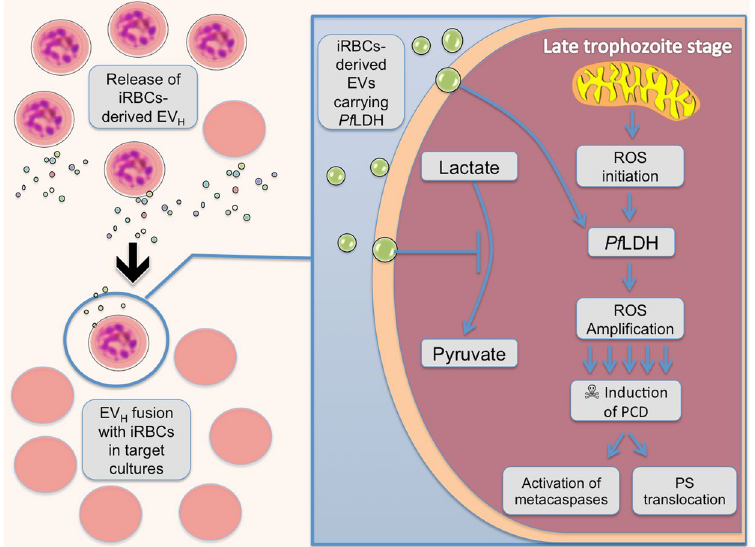
Figure 9. Diagram of the hypothesized action of Pf LDH in iRBCs after being transported by EVs. Density stressed cultures release EVs which cargo (PfLDH) is able to affect low density populations inducing death through apoptotic events triggered by this enzyme. PfLDH could inhibit the conversion of lactate to pyruvate producing an excess of the former which is detrimental to the parasite. Also, PfLDH could increment the production of ROS and the induction of apoptotic events leading to the suicide of the individual